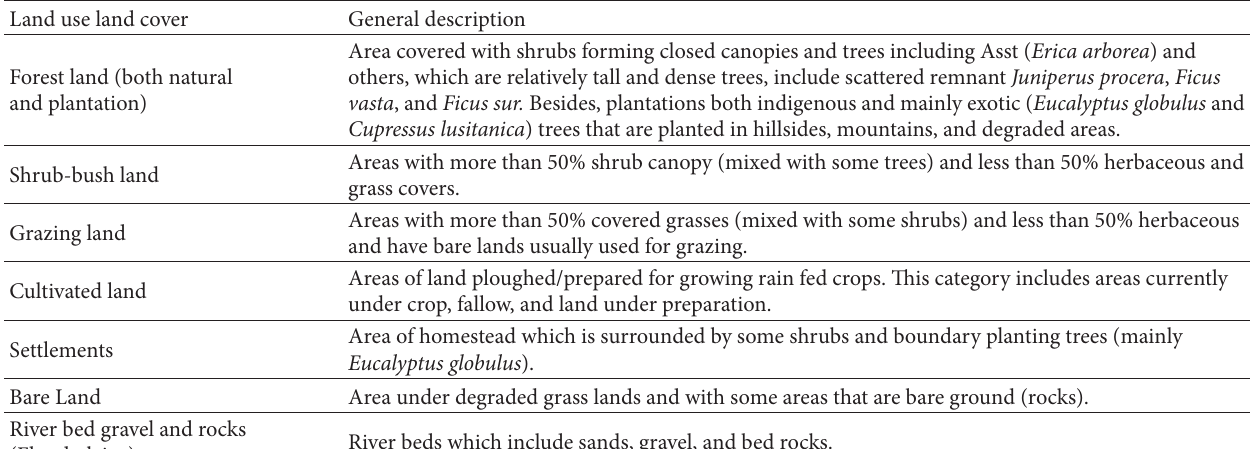
Table 1: Descriptions of LULC categories for the study